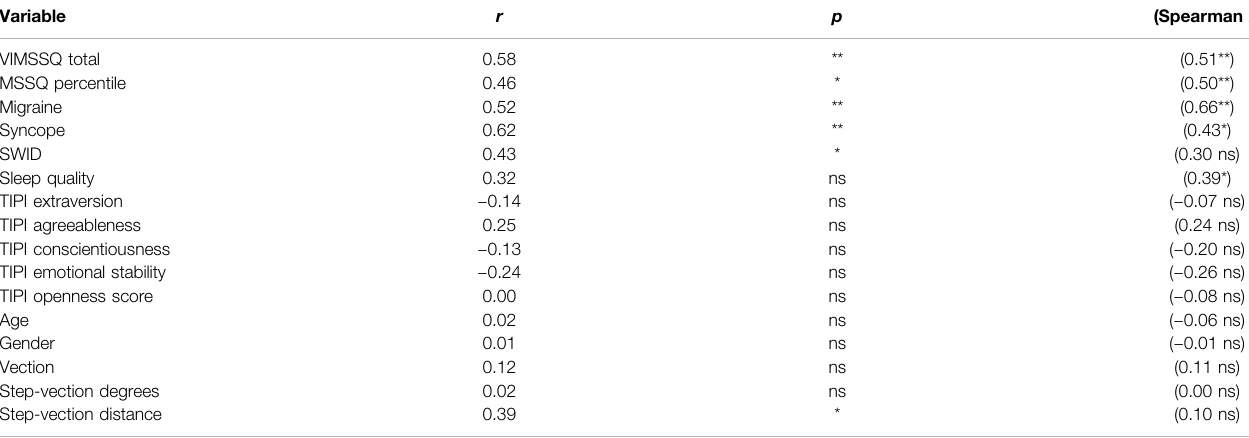
TABLE 4 | Correlations of VIMSSQ and other variables with the Simulator Sickness Questionnaire (SSQ) as the metric of visually induced motion sickness after exposure to the visual stimulus video.